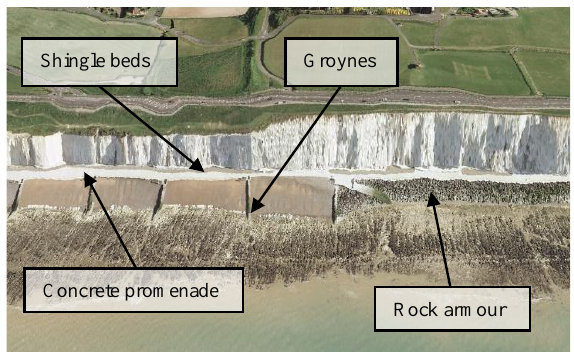
Fig.6. Visual example of shoreline changes 72 73 Fig. 6. Visual example of shoreline changes